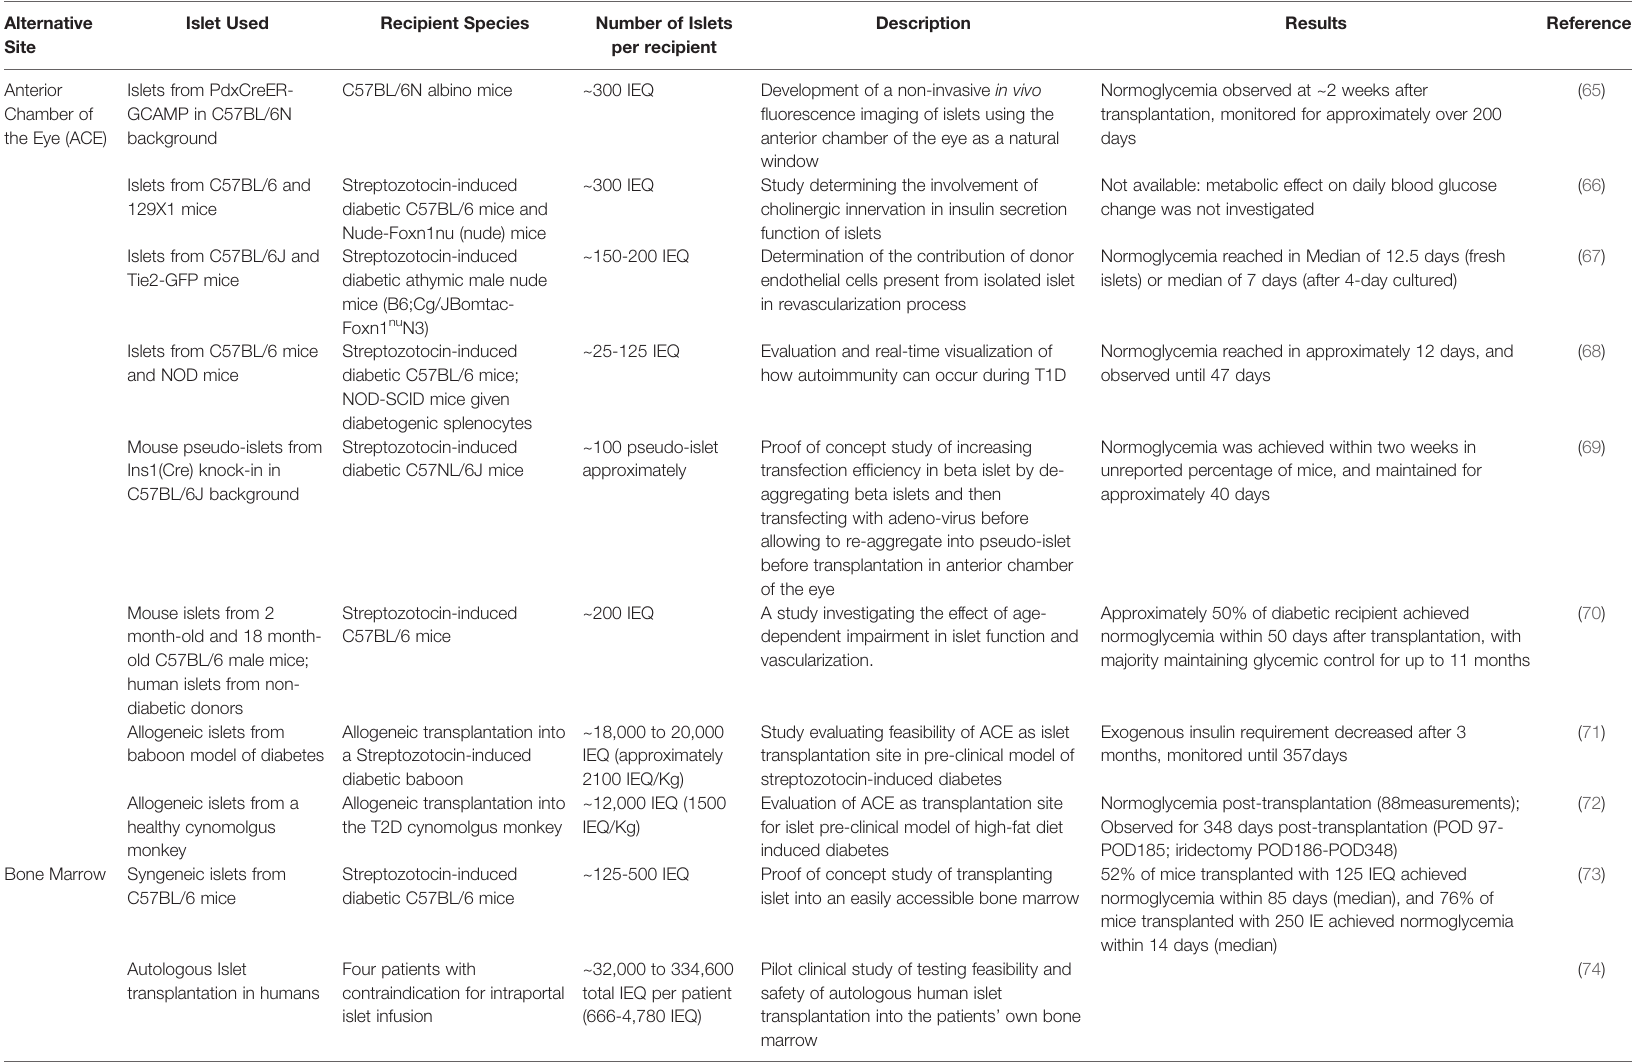
TABLE 1 | Summary of Transplantation Sites, Biomaterials and Resident immune